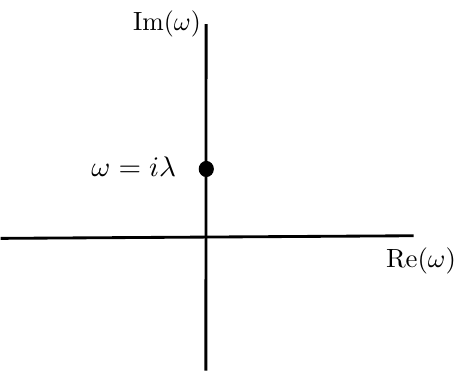
Figure 5 . Chaos is described in our framework through a pole (at ! = i(cid:21) ) in the upper half complex frequency plane of the retarded Green function of hydrodynamic variable (cid:27) ( t ). Such a pole does not indicate an instability, since it originates from a symmetry of the quantum hydrodynamics.